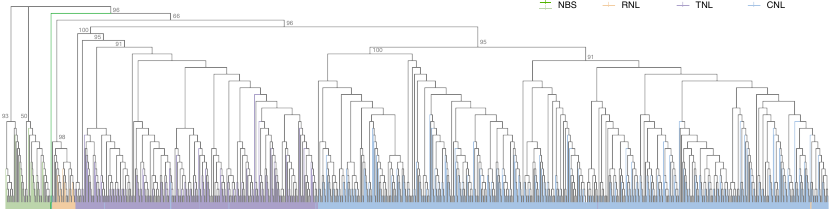
Figure A1. Phylogeny of NBS domains of NLRs. NLRs of three subclasses (RNL, TNL, CNL) of papaya and nine selected species were used to construct the NBS domain tree, in which NBS genes from Rhodophyta were used as the outgroup. The dark green indicates the two NBS genes used as the outgroup in Figure 4A. The numbers at the nodes mean branch support values, which are evaluated by the Shimodaira–Hasegawa test.